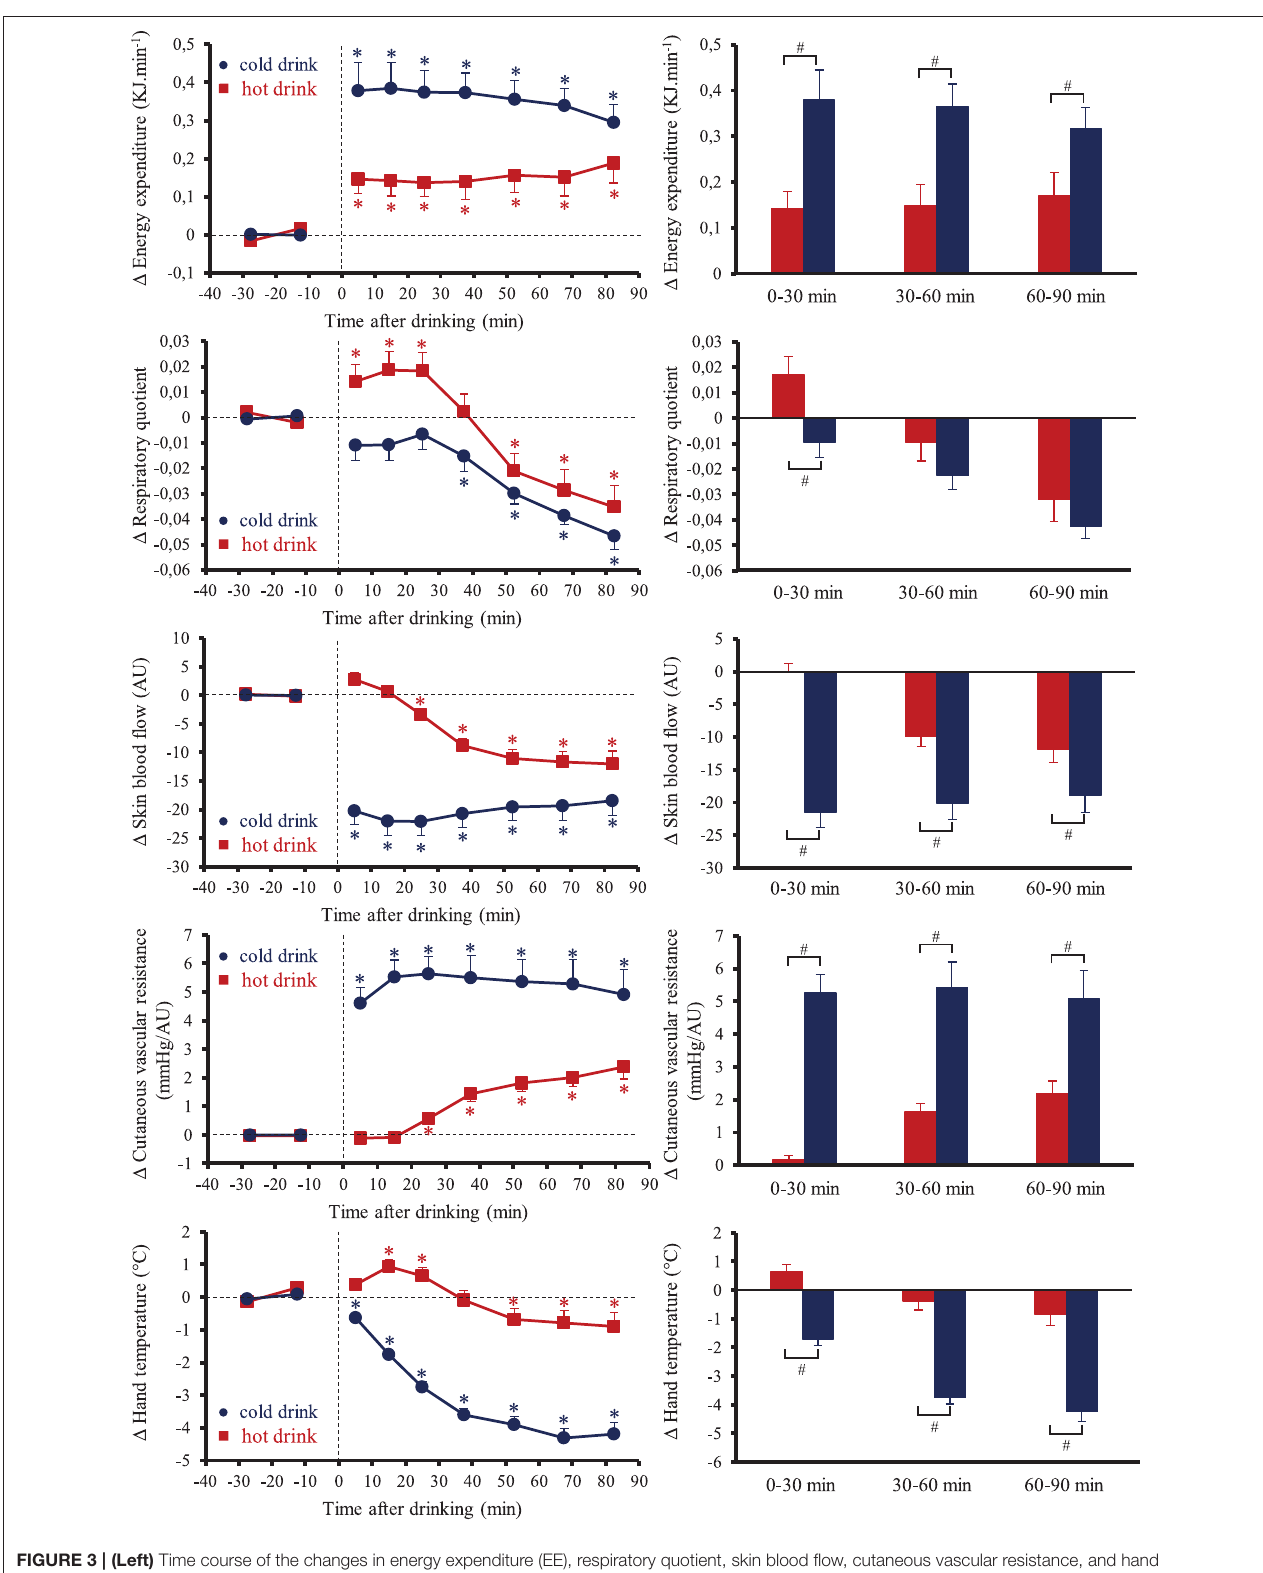
FIGURE 3 | (Left) Time course of the changes in energy expenditure (EE), respiratory quotient, skin blood flow, cutaneous vascular resistance, and hand temperature. (Right) Mean responses averaged over 0–30, 30–60, and 60–90min relative to baseline values and presented as a delta (i.e., average over 0–30, 30–60, and 60–90min post-drink period, respectively, minus the average over the 30-min baseline period). Drinks: hot tea ( (cid:4) and ); cold tea ( (cid:8) and ). * p < 0.05 significant differences over time from baseline values; # p < 0.05 significant differences between responses to the drinks.